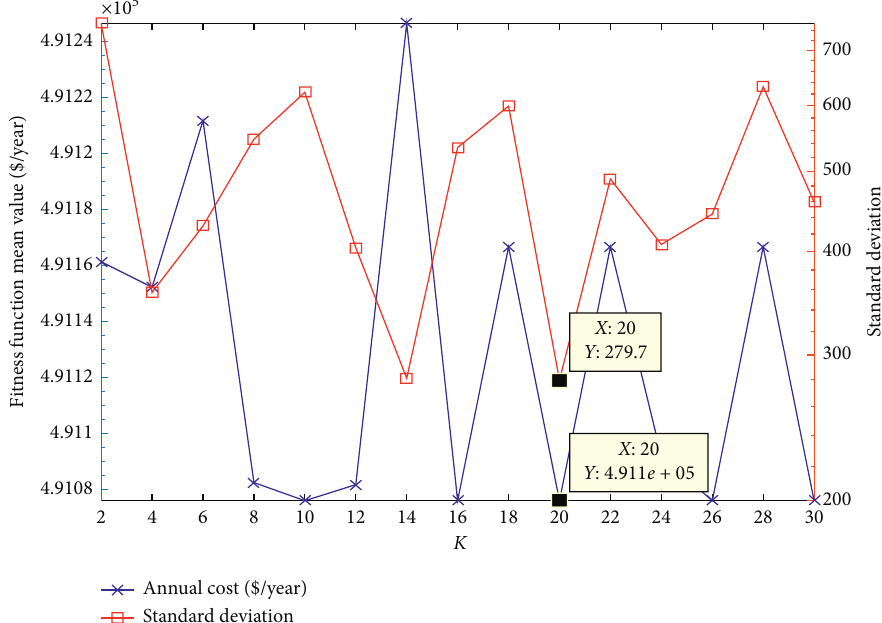
Figure 7: Impact for the local search limit parameter K with j